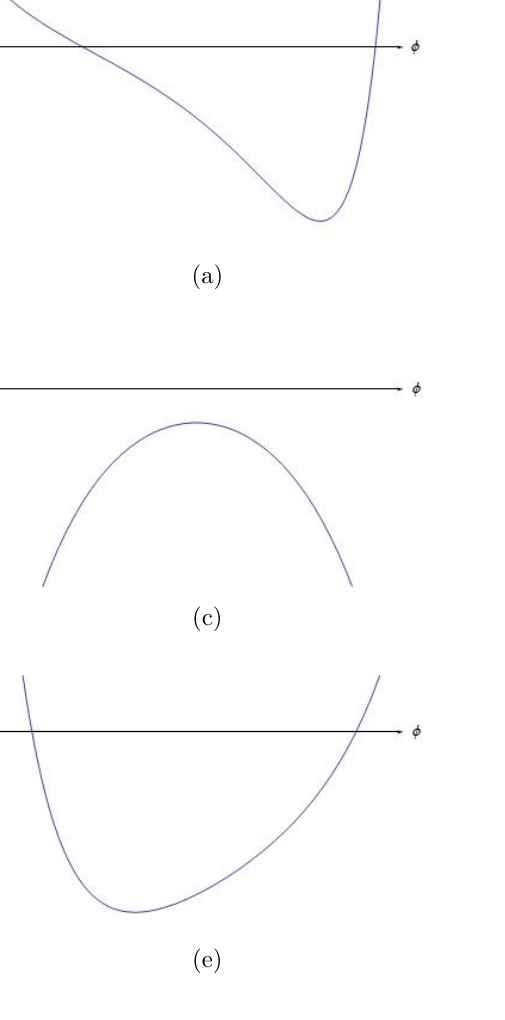
Figure 1 . Vacua potential